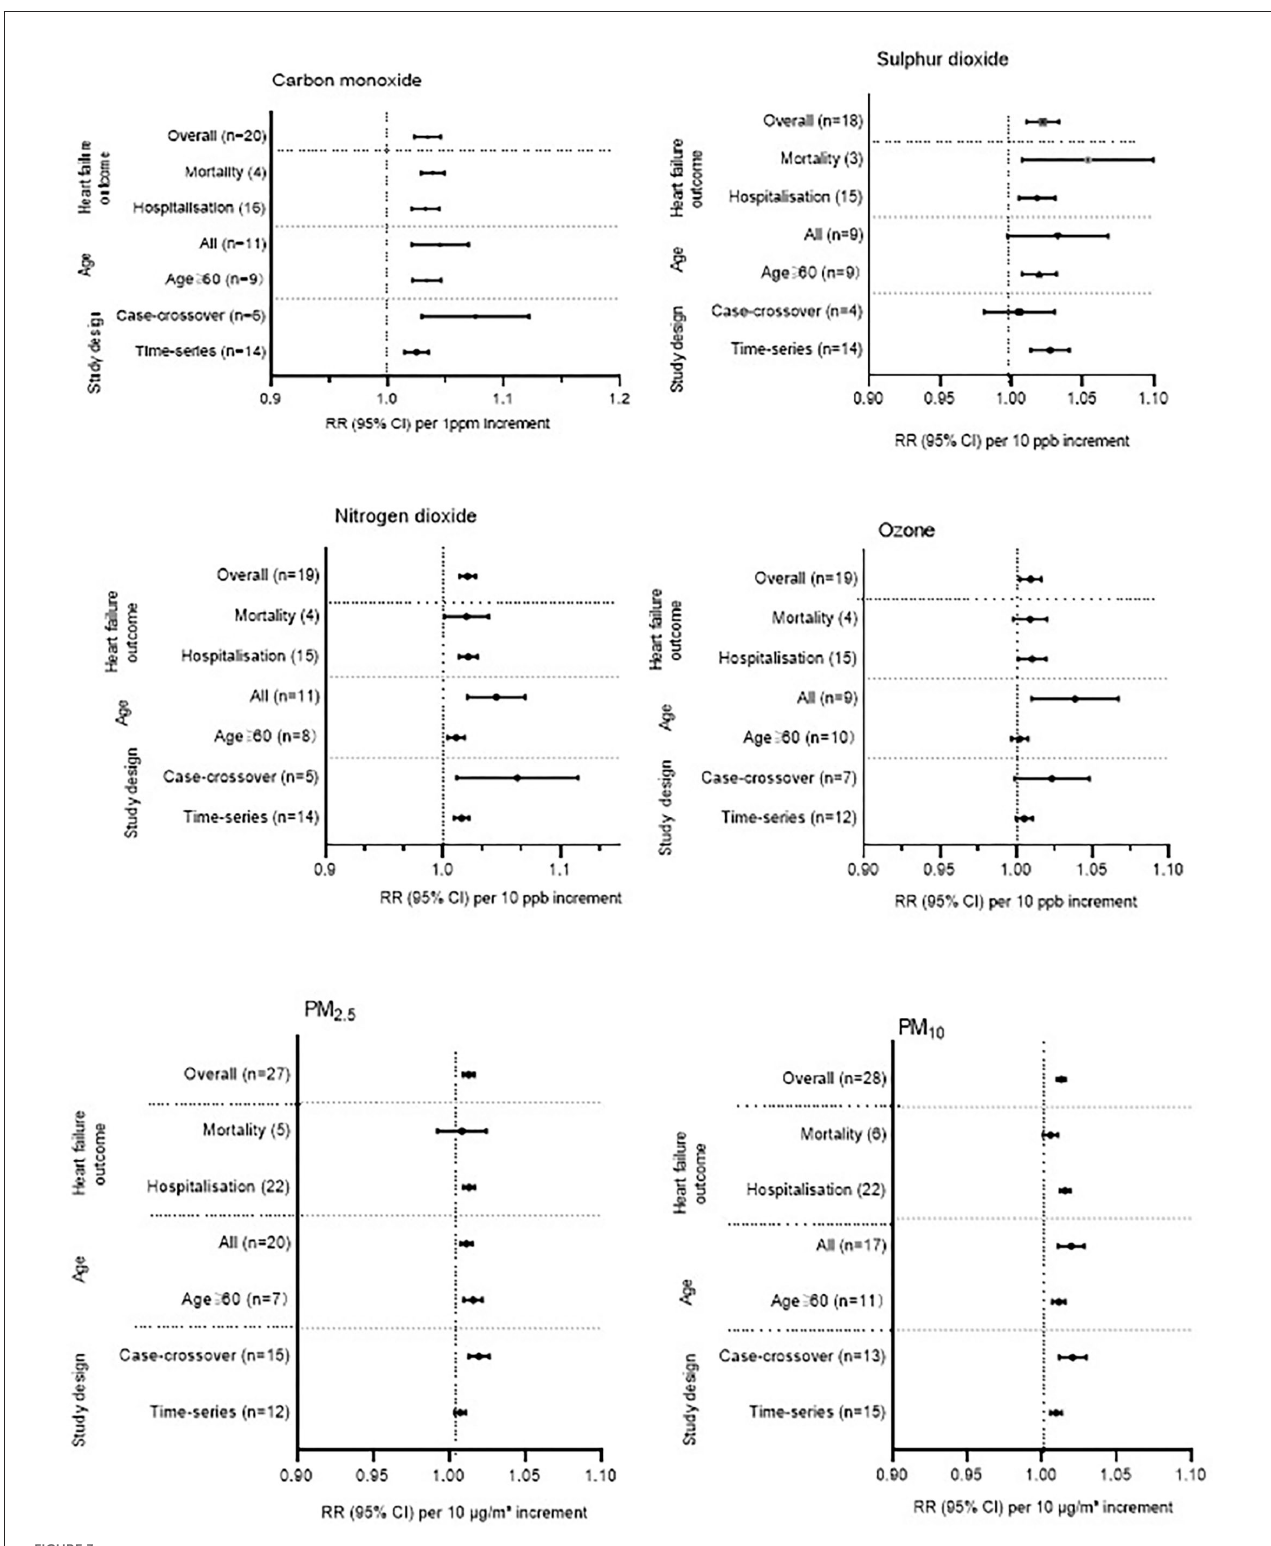
FIGURE3 Additional analysis across all gaseous and particulate air pollutants. Some studies provided separate estimates for all age groups and for people older than 65 years. This study, therefore, appears two times in the additional analysis when stratified by age. For the overall analysis, we have used the estimates provided for all age groups. Some studies provided separate estimates stratified by study design and, therefore, appear twice in the additional analysis. For the overall analysis, we used the estimates provided for the time-series study design. ppm, parts per million; ppb, parts per